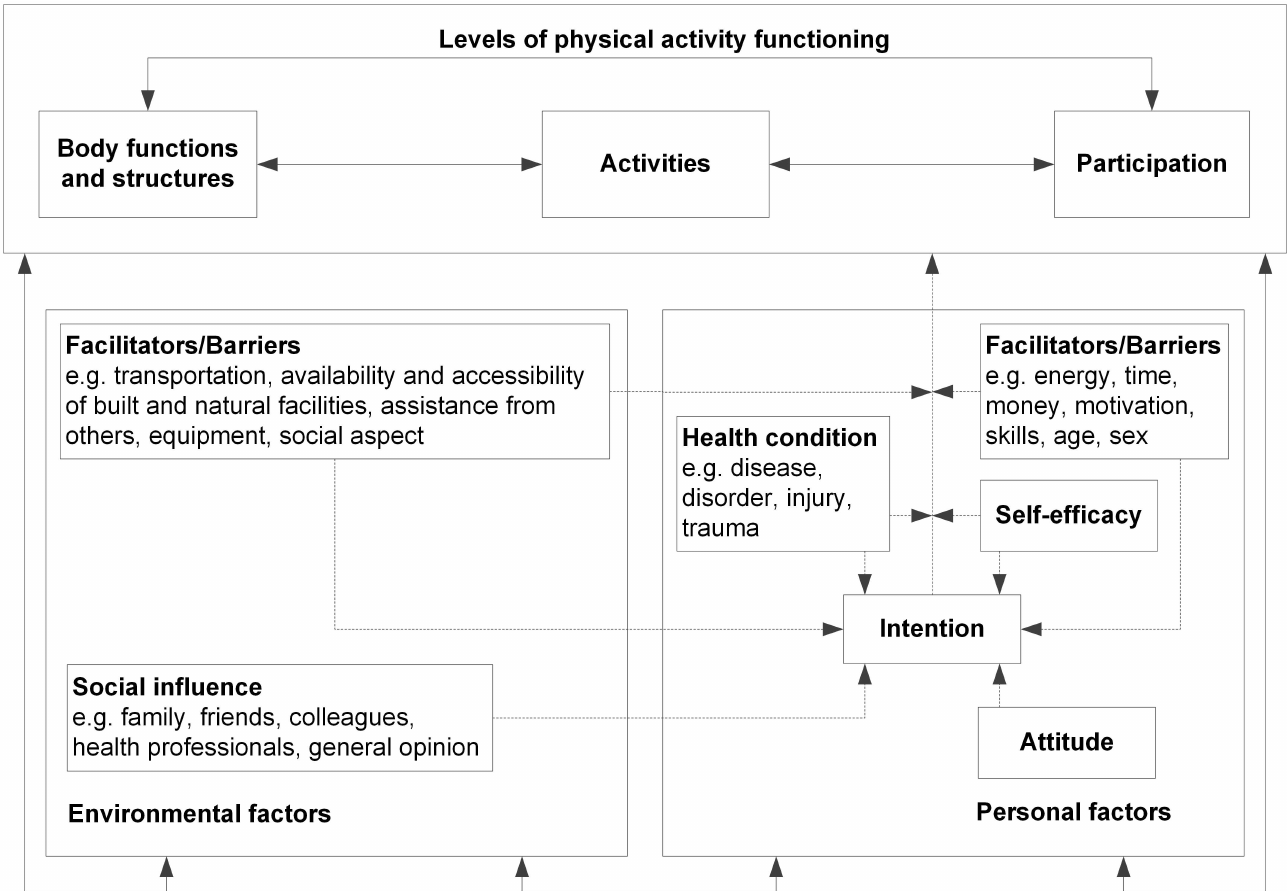
Fig 1. Physical Activityfor People witha Disability (PAD) model. Reprintedfromvan der Ploeg et al., 2004 [34] undera CC BY license, with permissionfromSpringer, originalcopyright 2004.